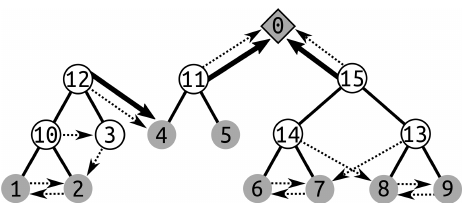
Figure 1. A depression hierarchy of the topography depicted in Fig. 2 generated by a process shown in Fig. 7. Dotted arrows in- dicate geolinks, solid lines indicate links between depressions and meta-depressions, and solid arrows indicate oceanlinks. (11), (12), and (15) are all roots of binary trees. In each of several binary trees, water fills the tree from bottom to top before overflowing into a neighboring tree or the ocean. As (1) fills up, it overflows through its geolink (the dotted arrow) into (2). Both of these then begin to fill (10), a larger depression containing both, as indicated by the solid lines between (10) and both (1) and (2). When (10) overflows, it begins to fill (3) through the dotted geolink arrow. When (3) over- flows, it tries to fill (2), but finds it full. Therefore, both (3) and (10) begin to fill (12). Topologically, (12) flows into (4); however, the reverse is not true. This is because the depression tree rooted at (12) must actually be uphill of (4). Thus, (12) notes that (4) is its parent (solid arrow) and the depression into which it overflows (geolink, dotted arrow), and (4) makes an oceanlink to (12), as implied by the solid arrow, but does not count it as a child. Both (11) and (15) flow into the ocean (0), which may have an infinite number of children. A cross-sectional view of the landscape described by this depression hierarchy is shown in Fig. 2.